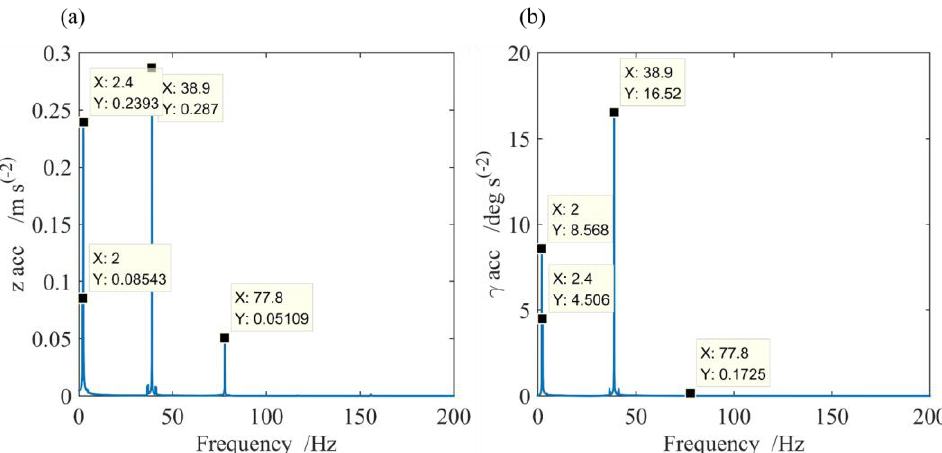
14 mps v = 14 mps v =